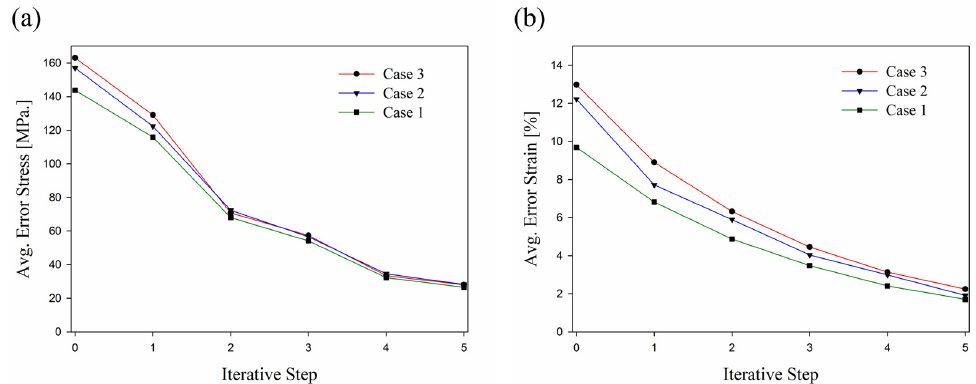
Figure 5. Convergence analysis for the ferrite phase at 25% global true strain. ( a ) Stress and ( b ) strain by the proposed iterative method with different iterative steps.